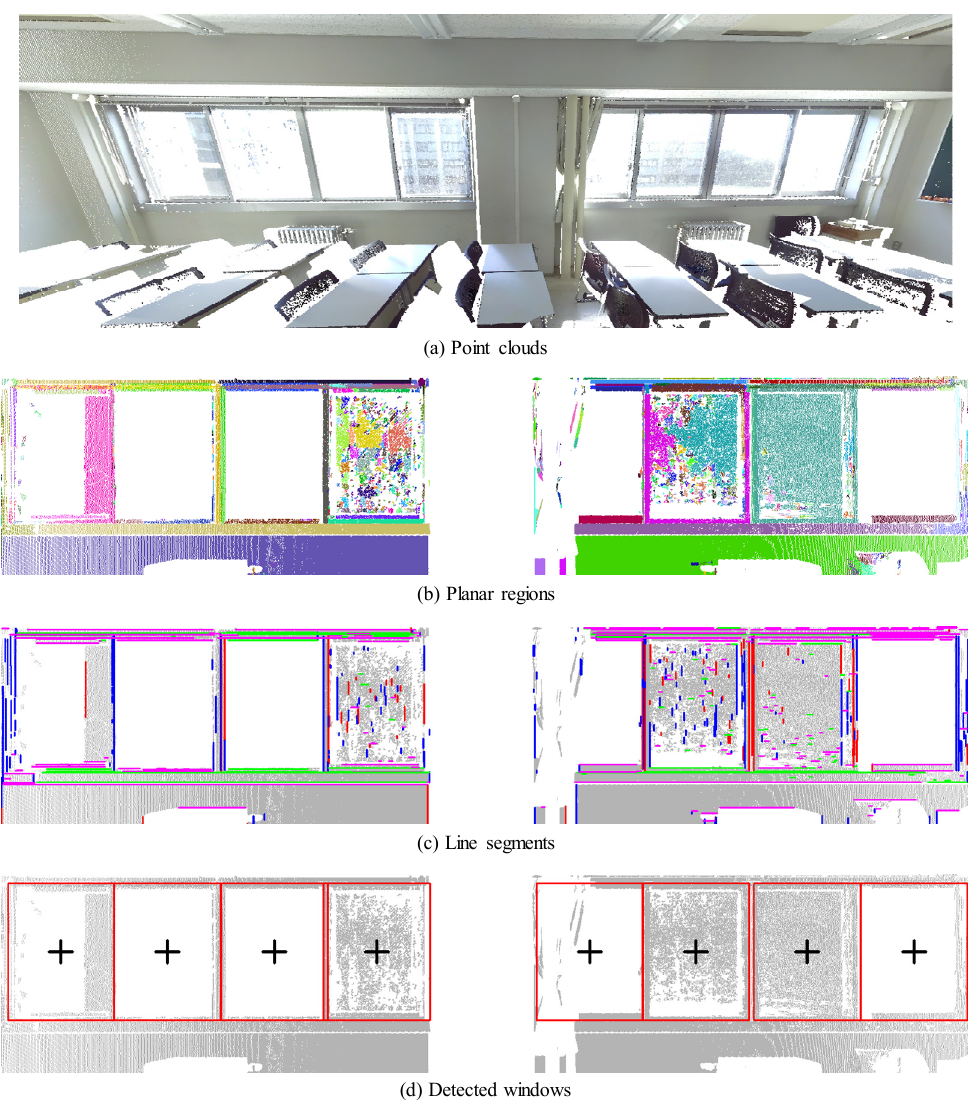
Figure 7. Results of window